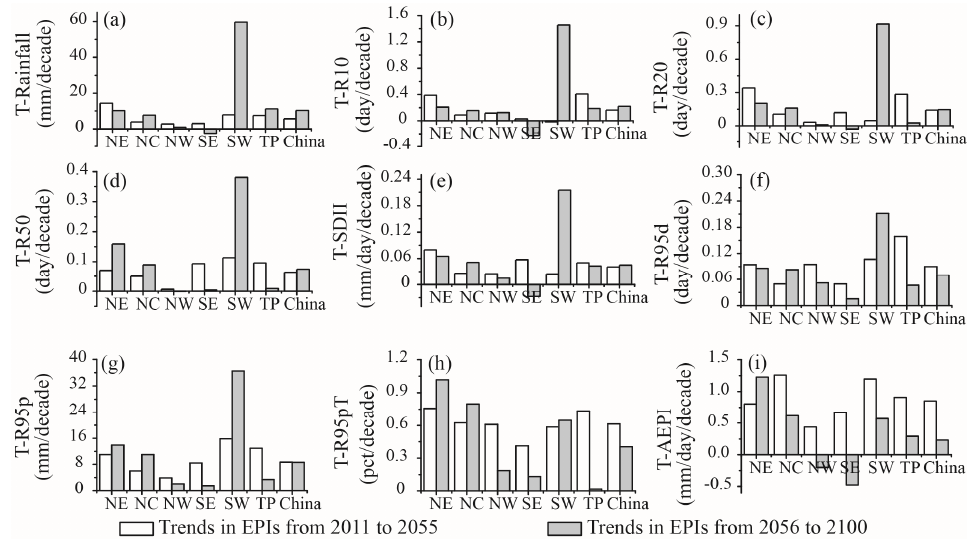
Figure 6. Trends of decade in regional extreme precipitation indices in the next 90 years in China: ( a ) trends in rainfall, ( b ) trends in R10, ( c ) trends in R20, ( d ) trends in R50, ( e ) trends in SDII, ( f ) trends in R95d, ( g ) trends in R95p, ( h ) trends in R95pT, and ( i ) trends in AEPI. The white bars represent the trends from 2011 to 2055, and the gray bars indicate the trends from 2056 to 2100.